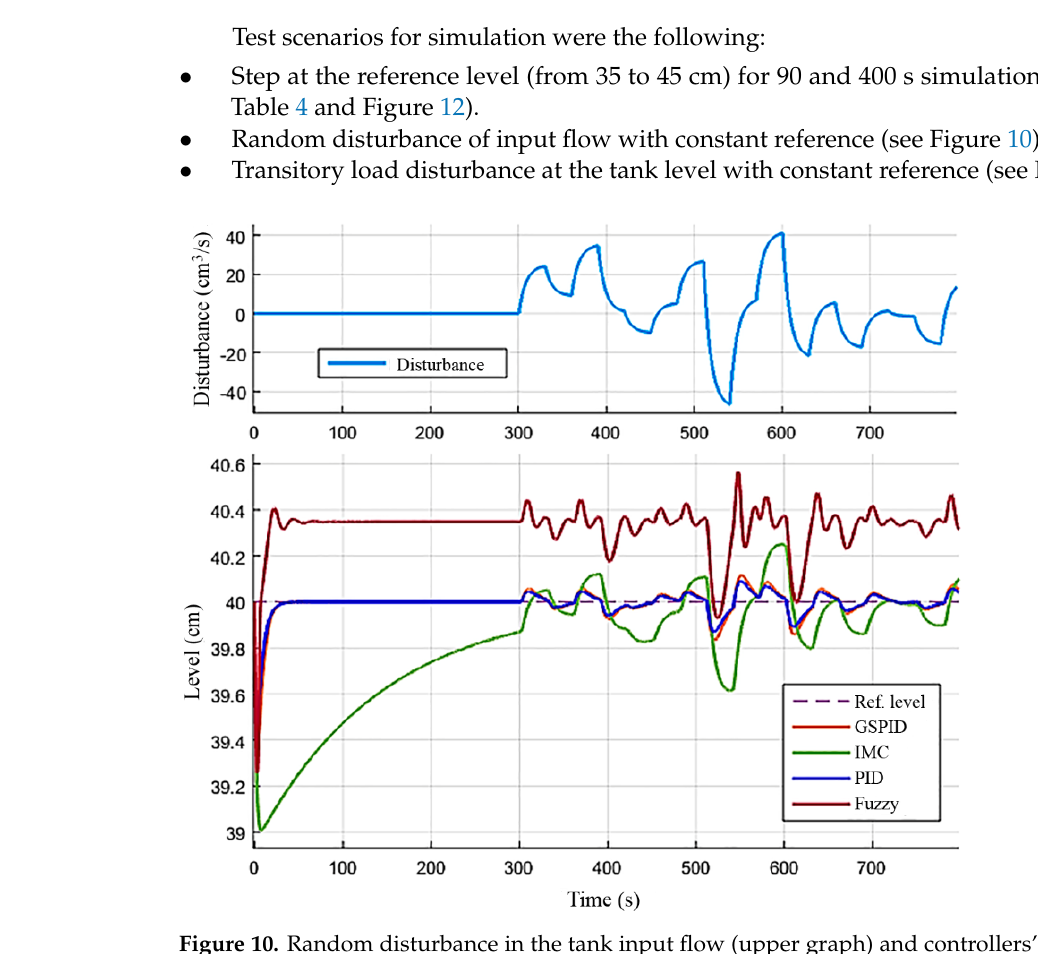
Figure 10. Random disturbance in the tank input flow (upper graph) and controllers’ response to this disturbance (lower graph).